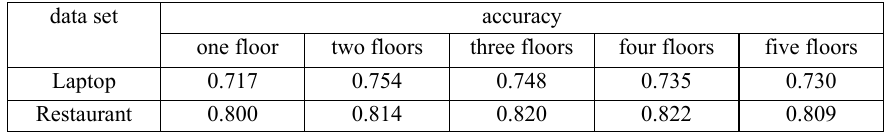
Table 3. The effect of the number of attention layers on accuracy.